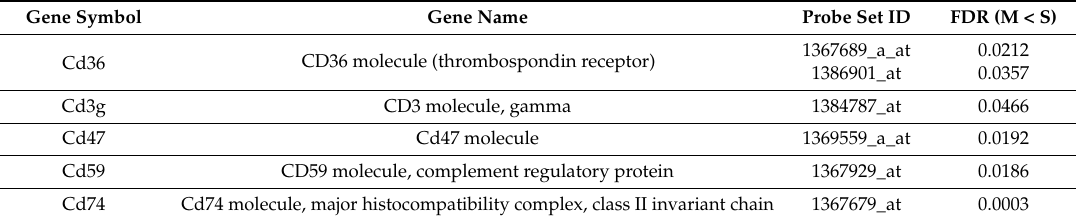
Table 3. CD molecules found among the differentially expressed genes from blood samples. Gene